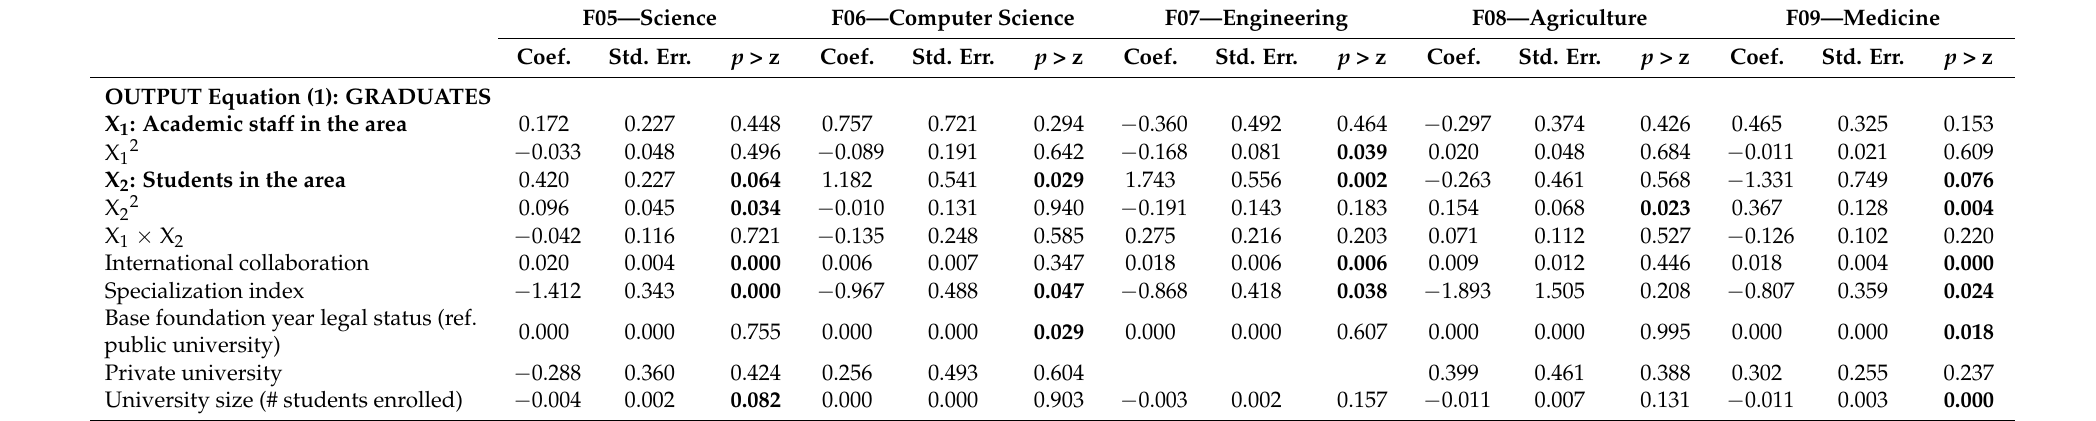
Table 3. SUR Estimates: extended Translog